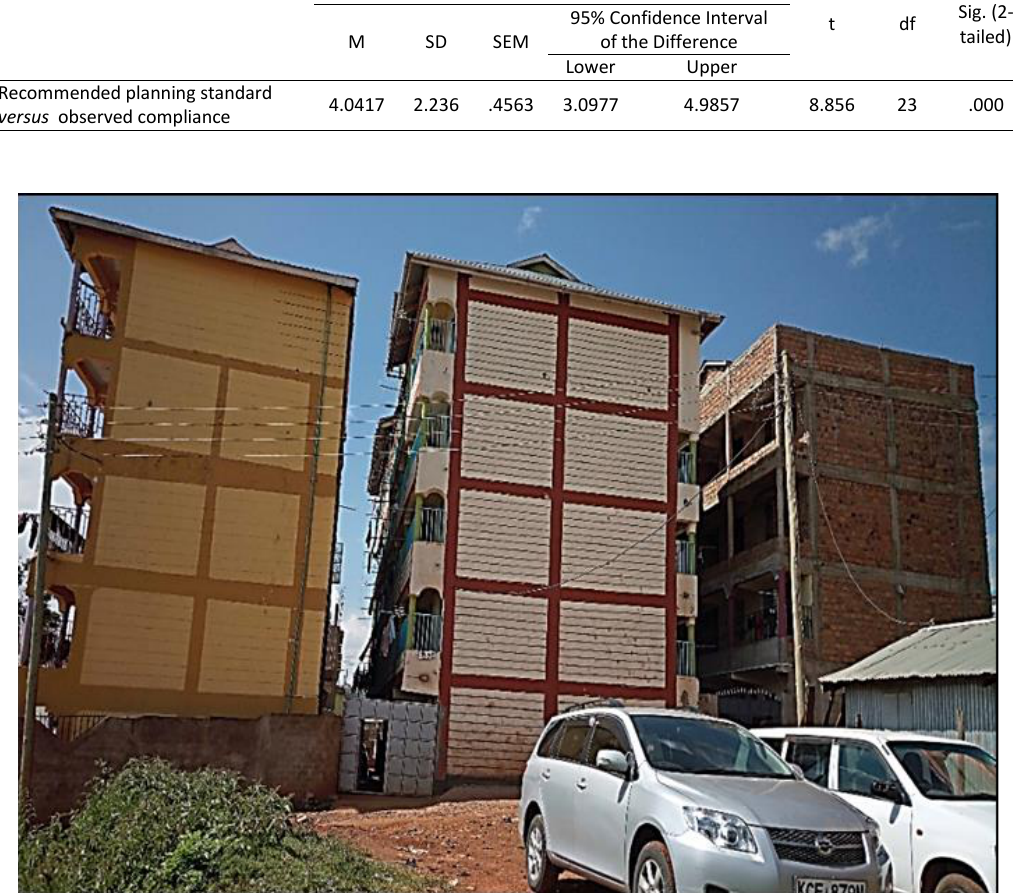
Fig. 5: Residential apartments with no parking in Nyanchwa